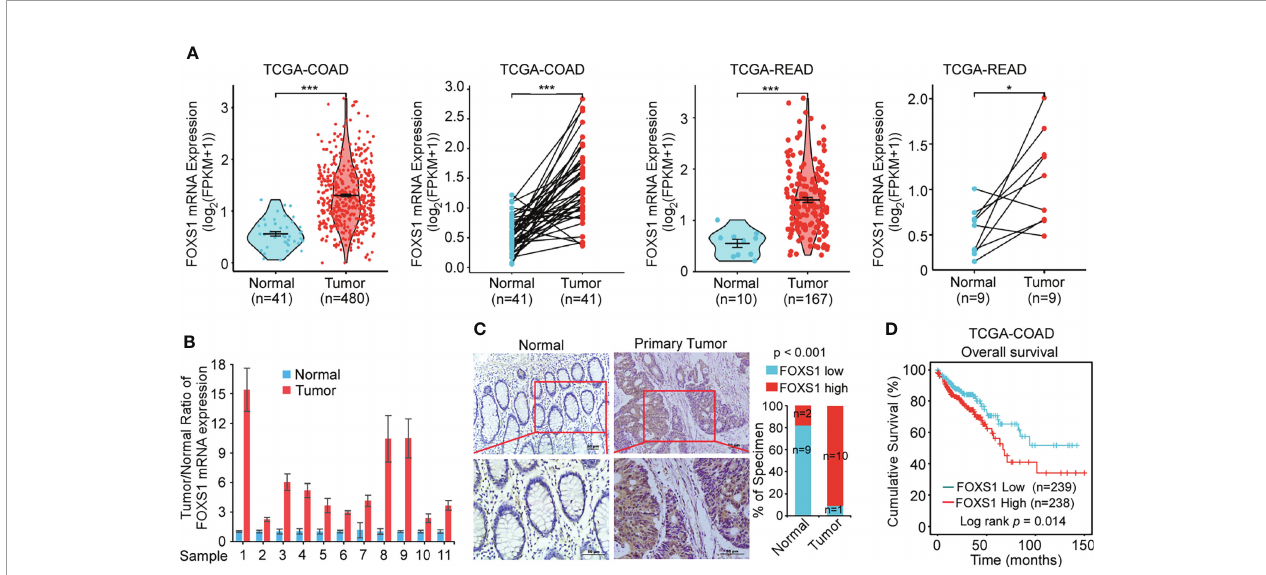
FIGURE 1 | FOXS1 is upregulated in CRC and associated with a poor prognosis. (A) Analysis of FOXS1 expression in CRC compared with normal tissues in TCGA COAD and TCGA READ databases. FOXS1 expressions in paired CRC cancer tissues and adjacent normal tissues in TCGA COAD and TCGA READ datasets were also compared. (B) Real-time PCR analysis of FOXS1 expression in paired human CRC tissues and adjacent non-cancerous tissues. (C) The expression of FOXS1 in normal intestinal tissues and CRC tissues was examined by IHC. Representative IHC images (left) and correlation analysis (right) are shown. Scale bars: 50 µm. (D) Kaplan – Meier analysis of overall survival in all CRC patients in TCGA database according to FOXS1 expression (log-rank test, p = 0.014). * p < 0.05, *** p <